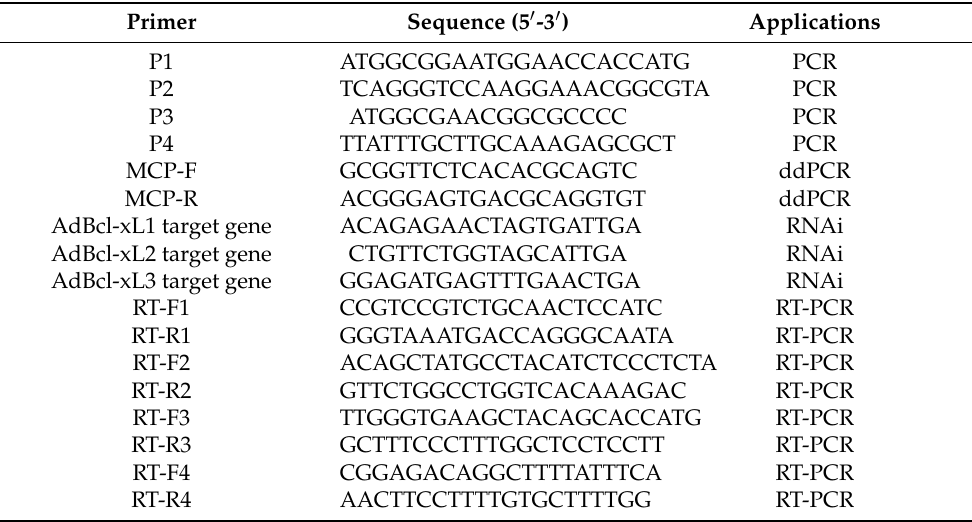
Table 1. Primers used in this